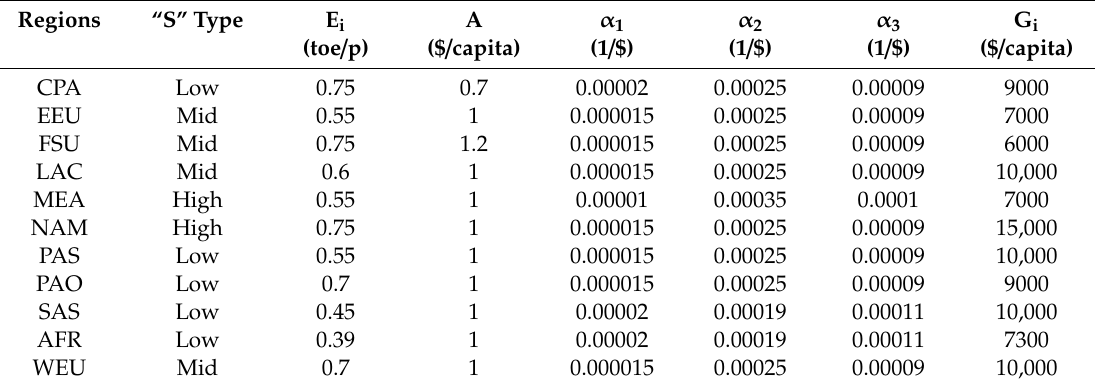
Table 5. Major boundary conditions and